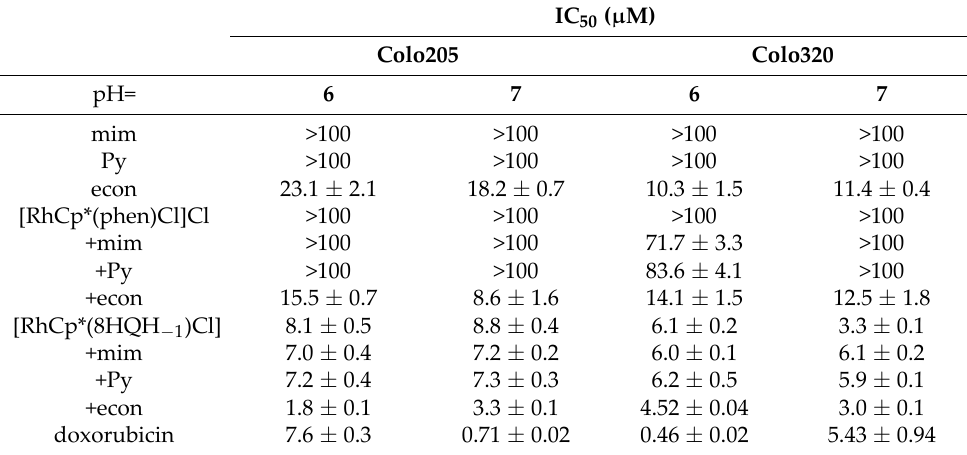
Table 3. In vitro cytotoxicity expressed as IC 50 values ( µ M) for the [RhCp*(phen)(N)] 2+ and [RhCp*(8HQH − 1 )(N)] + complexes ((N) = econ, mim, or Py) in Colo205 and Colo320 human colon adenocarcinoma cell lines and at two different pH values. {72 h incubation